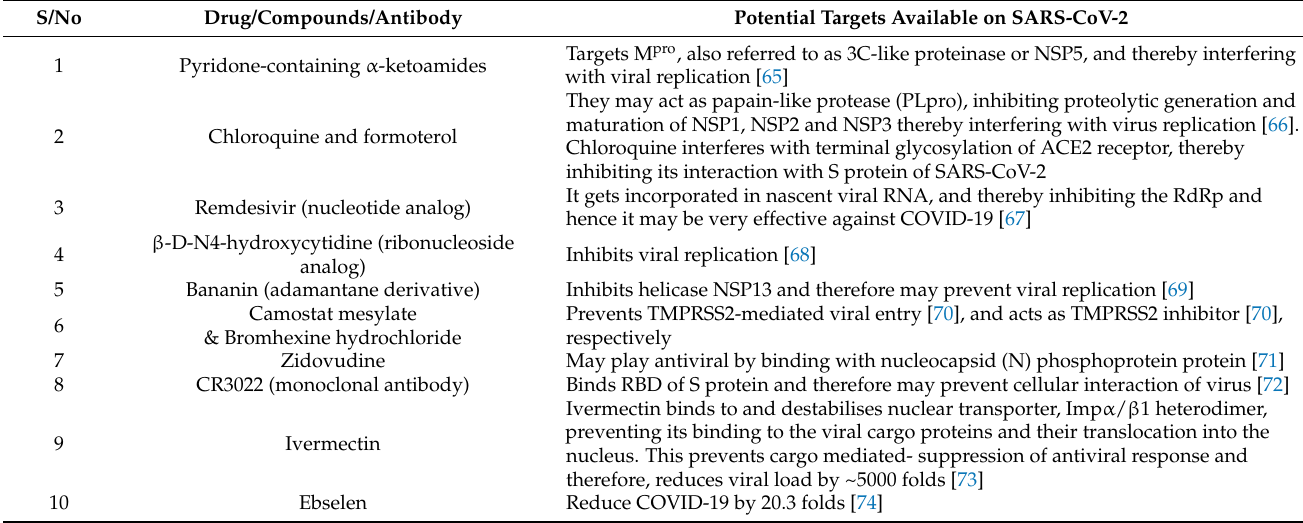
Table 2. Selected list of therapeutic molecules currently in clinical trial and their respective targets on SARS-CoV-2. S/No Drug/Compounds/Antibody Potential Targets Available on